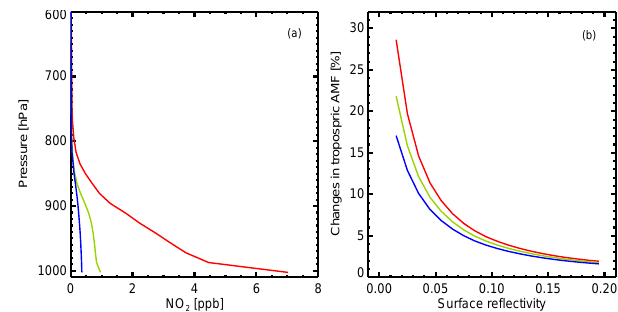
Figure 13. (a) November mean NO 2 profiles at three locations in the eastern US from the NASA GMI model; (b) air mass factor (AMF) change due to 0.01 change in surface reflectivity as a func- tion of surface reflectivity. Red: highly polluted profile; green: mod- erately polluted; blue: unpolluted